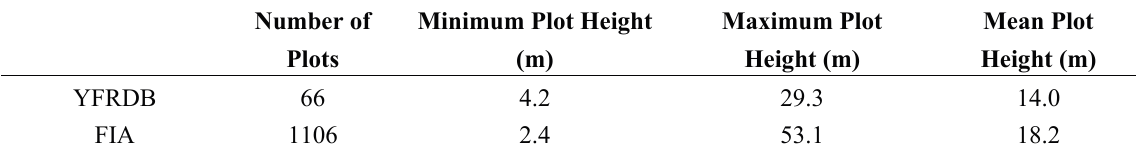
Table 2. Summarized field plot data.